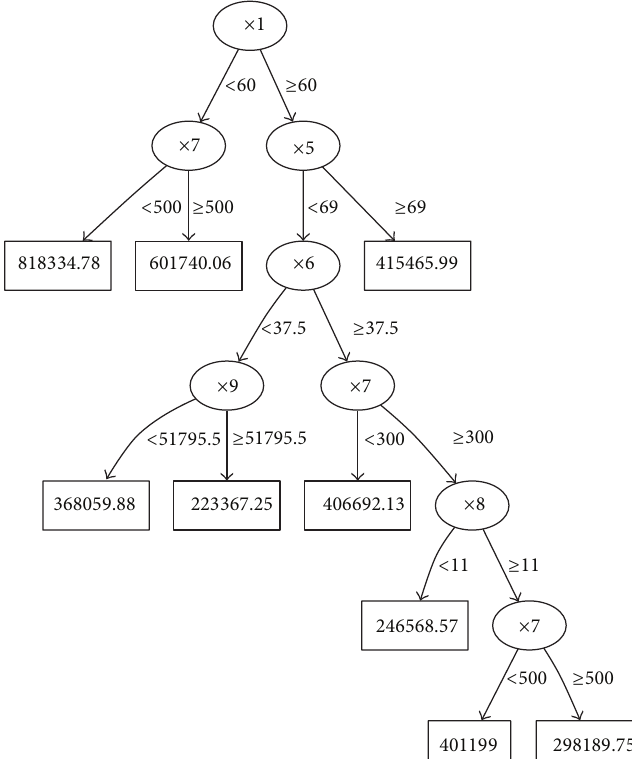
Figure 2: Model of the measured volume with a regression